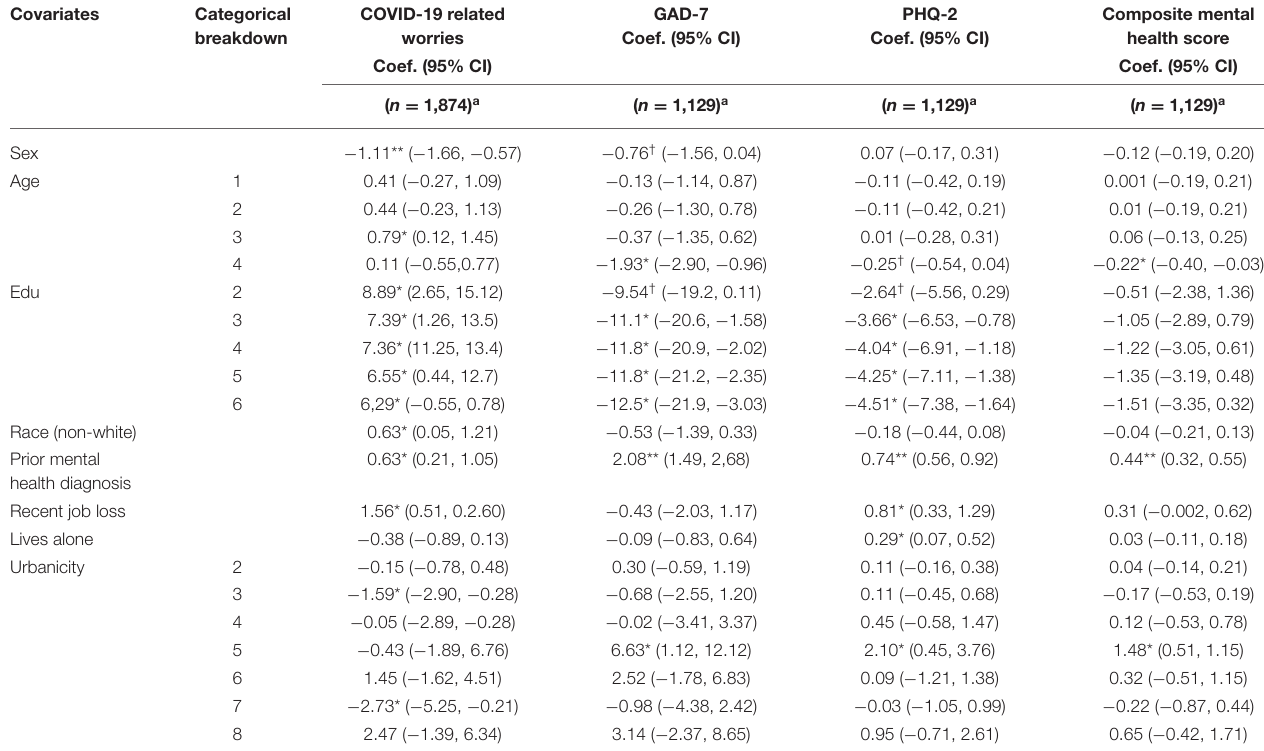
TABLE A2 | Full multivariate regression analysis with multilevel models of all covariates. Covariates